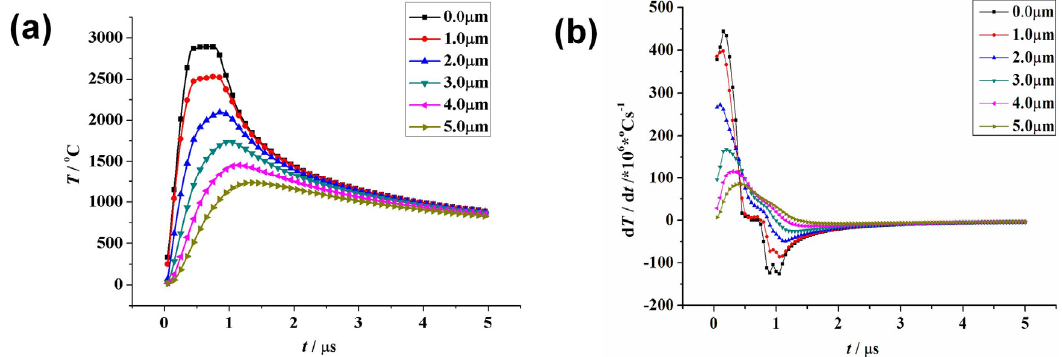
Figure 8. ( a ) Variation of the temperature and ( b ) the temperature gradient at different depth layers from the surface as a function of time.